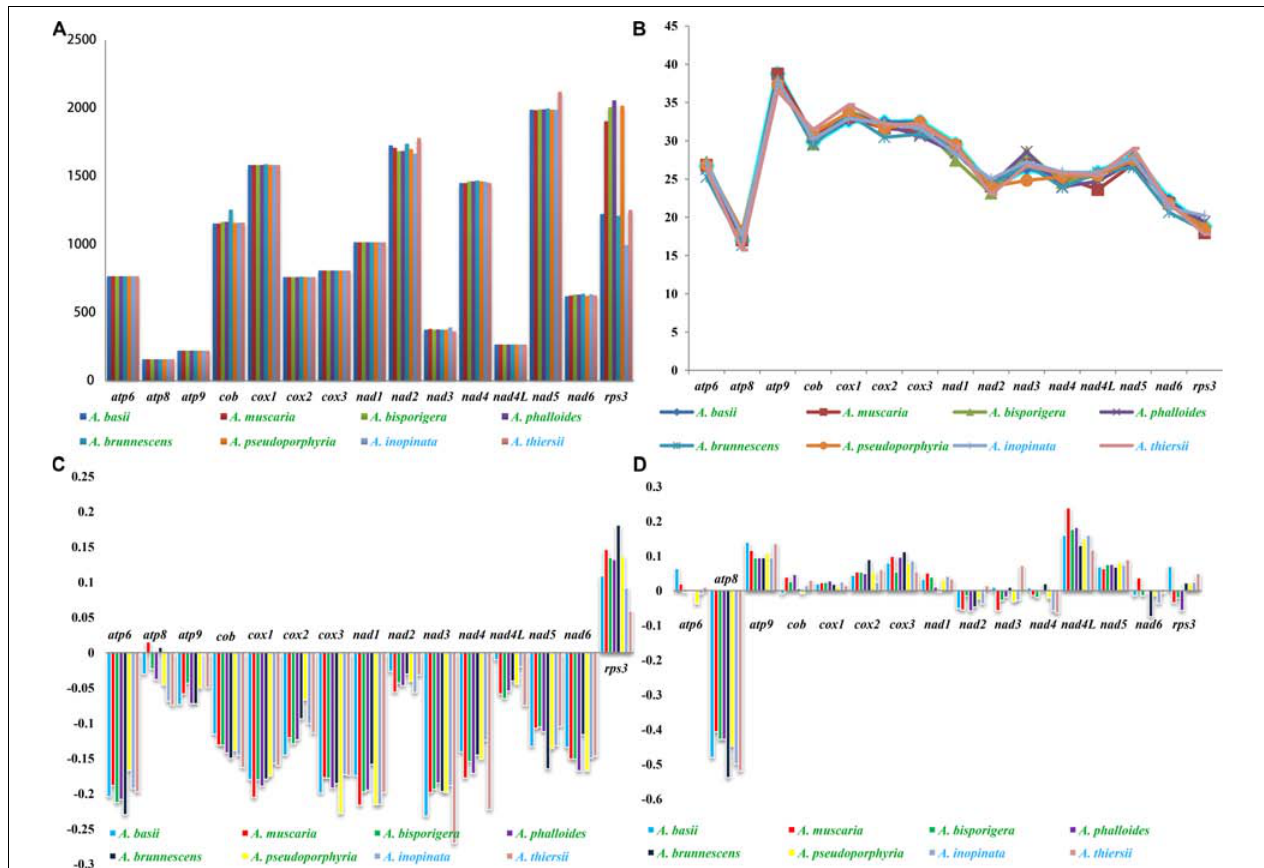
FIGURE 5 | Variation in the length and base composition of each of the 15 PCGs among the eight Amanita mitogenomes. The Amanita species with blue fonts are asymbiotic, while the species with green fonts are ectomycorrhizal. (A) Length variation of PCGs; (B) GC content of the PCGs; (C) AT skew; (D) GC skew.